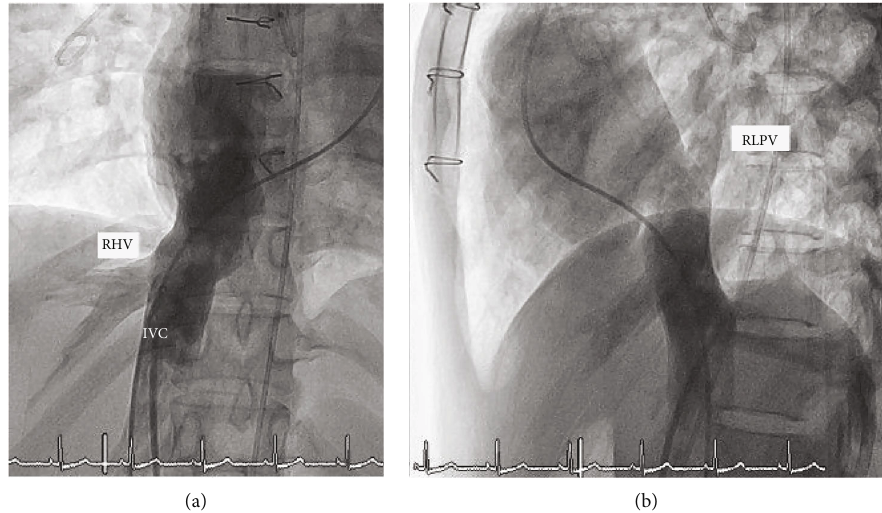
Figure 6: Angiography was performed in the inferior vena cava (IVC). The (a) anterior and (b) lateral views show the connection between the right lower pulmonary vein (RLPV) and the right atrium. The decision was made to place the lower end of the covered stent above the entrance of the left and right hepatic veins (RHV).